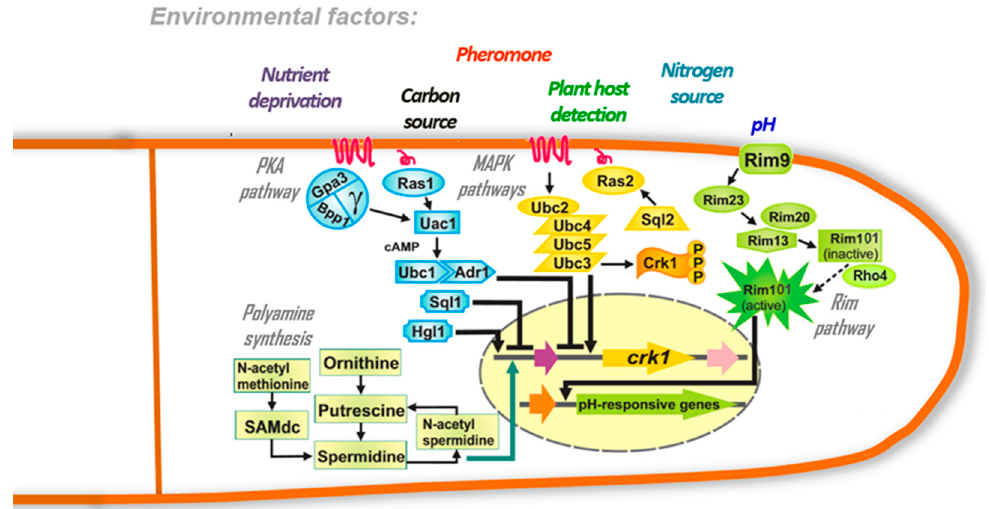
Figure 1. Schematic representation of the signal transduction and metabolic pathways involved in the Ustilaginomycetes multicellular growth. Several authors have suggested that the mitogen-activated protein kinase (MAPK) and cyclic AMP (cAMP) / protein kinase A (PKA) pathways are necessary for mycelium development (a simple multicellular structure observed in Ustilaginomycetes) (reviewed by References [32,45,55,56]). Polyamines, especially spermidine, are essential for the expression of the genes involved in the multicellular growth and the response to stress conditions [47,57–59]. Although the Rim pathway is not involved in the fungal multicellular growth, it is required to sense stressful environmental conditions such as pH [60–62], which is one of the most important inducers of multicellular growth in Ustilaginomycetes [13,35].